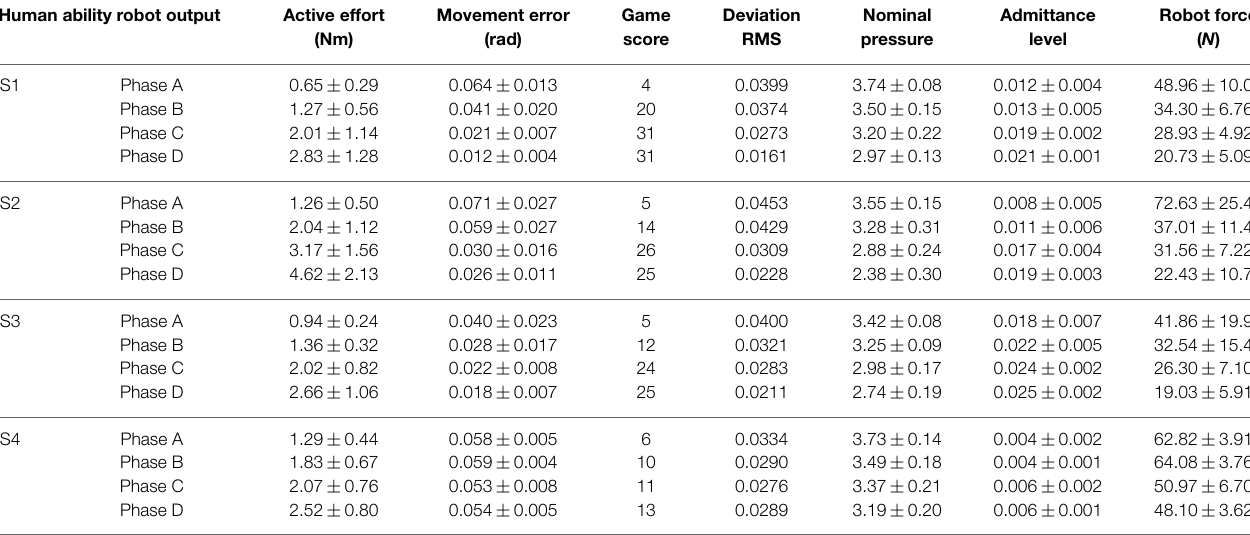
TABLE 1 | Statistical results of the involved four subjects in different phases A–D. Human ability robot